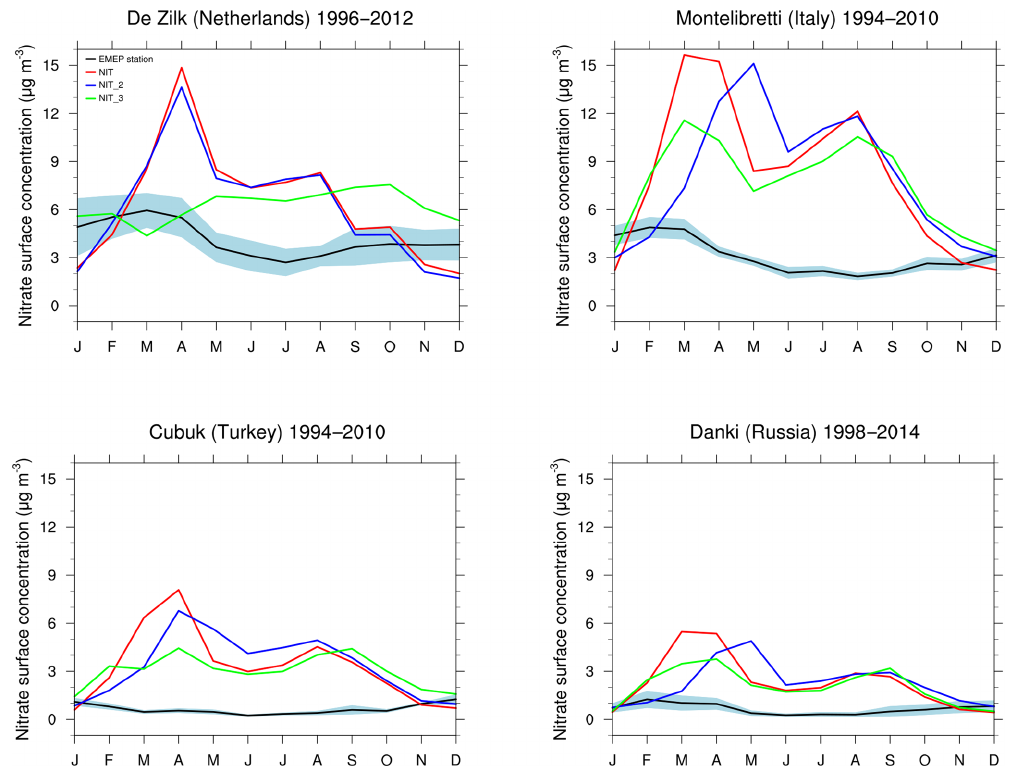
Figure 9. Monthly means of the surface nitrate concentration (µgm − 3 ) at the De Zilk, Montelibretti, Cubuk and Danki EMEP stations, for NIT (red), NIT_2 (blue) and NIT_3 (green) simulations. Observations are in black and the standard deviation associated with observations is in light blue.